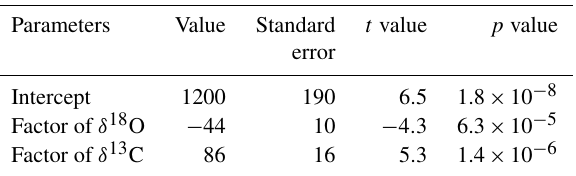
Table 4. A t test table of the multiple linear regression model for 4–309ka.